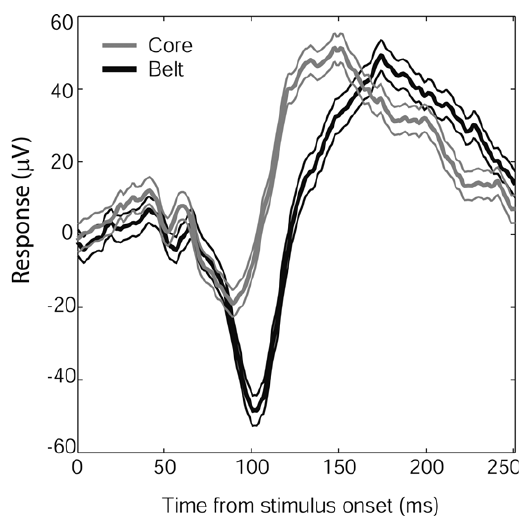
Figure 6. Time course of N100 face responses in auditory core and lateral belt regions. Mean responses (in μ V) from core electrode sites (gray, N = 18) and lateral belt (black, N = 61), ± SEM (thin lines). Although the core and lat- eral belt responses show a similar onset time and response slope, the lateral belt response continues, resulting in a longer latency to peak. A similar shift was seen in Monkey 2, whose mean response ( ± SEM) from core, 117(3.5) ms ( N = 34), preceded the mean response from belt, 128(6.4) ms ( N = 10).